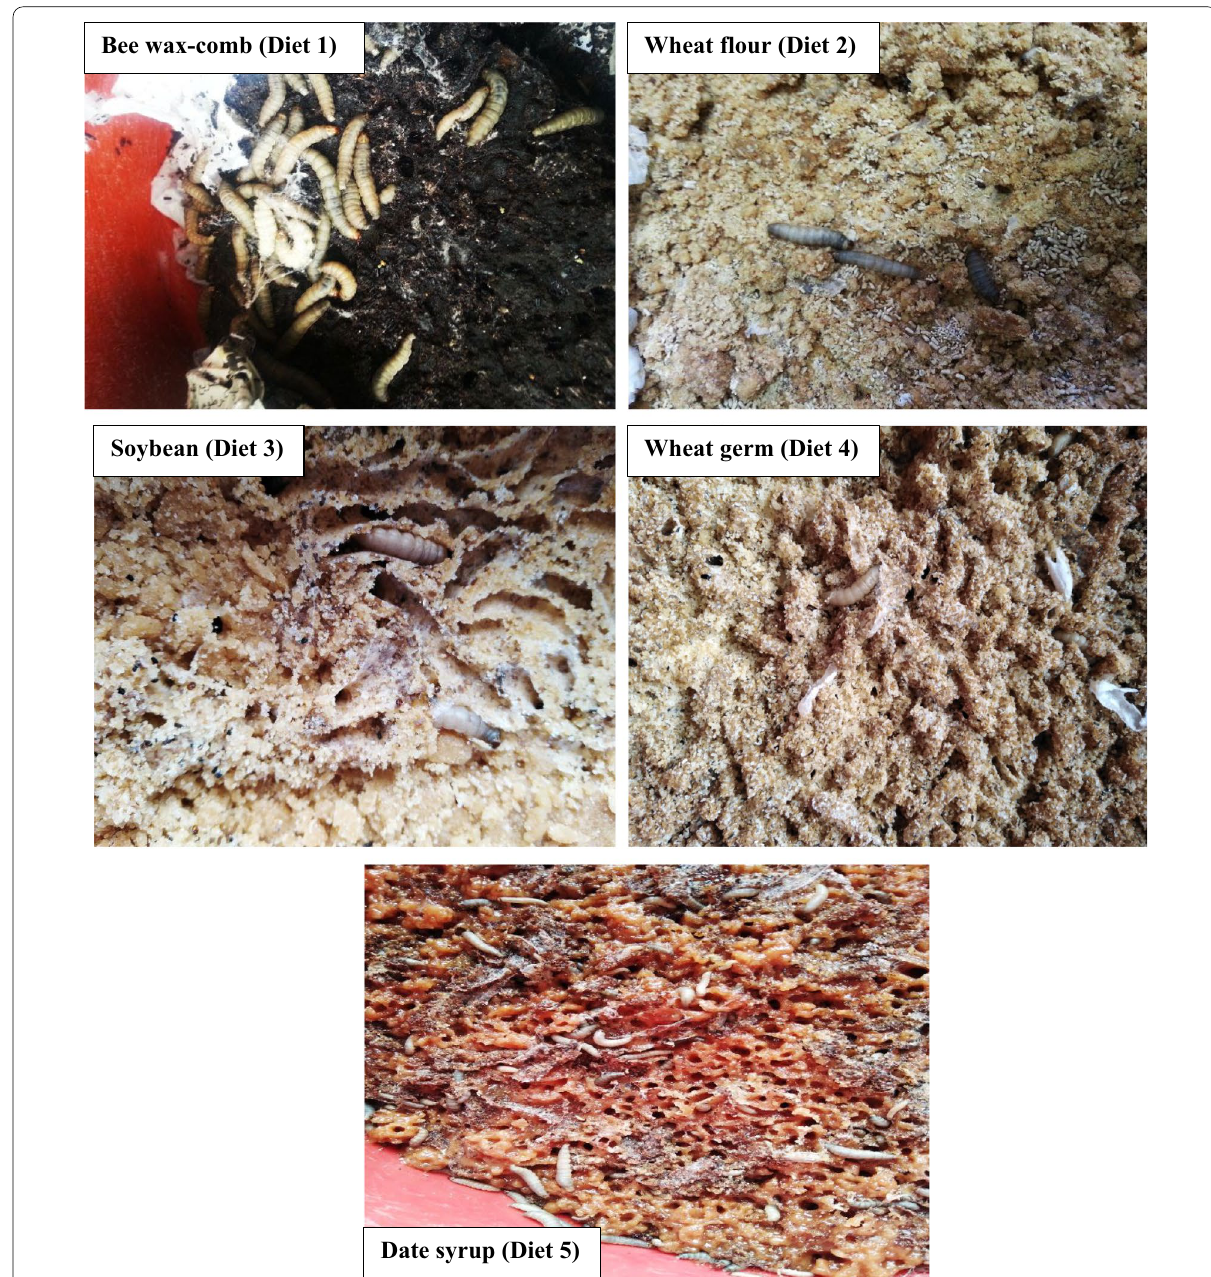
Fig. 1 Rearing the greater wax moth larvae, Galleria mellonella on five different tested